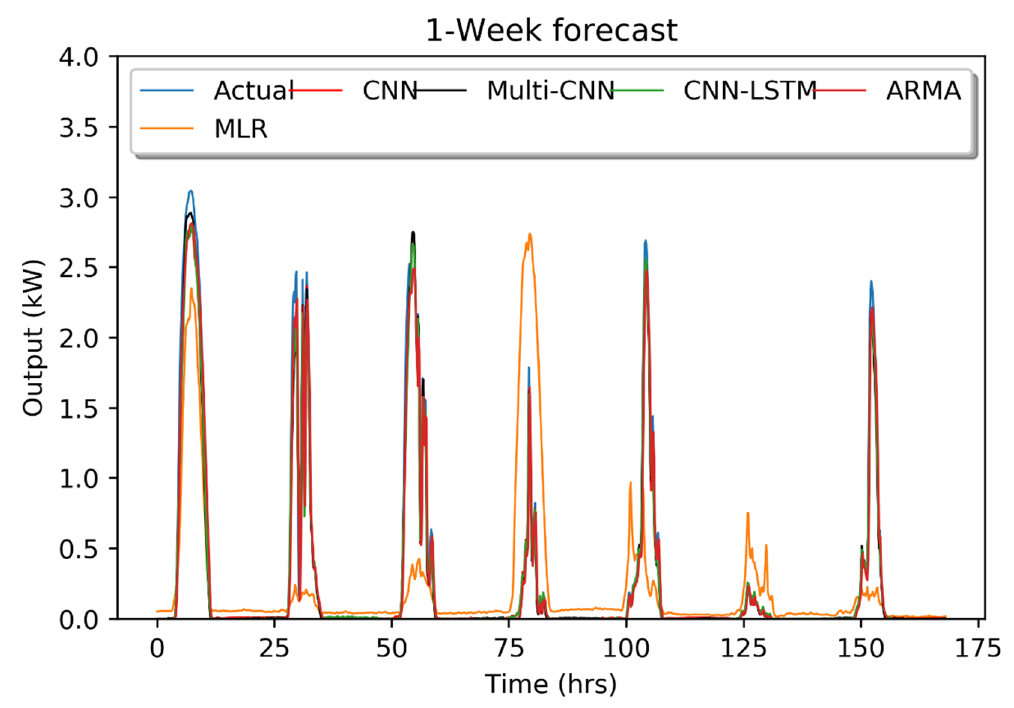
ff erent methods for the 1-Week forecast Figure 11. Comparison of different methods for the 1-Week forecast (winter). Figure 11. Comparison of di